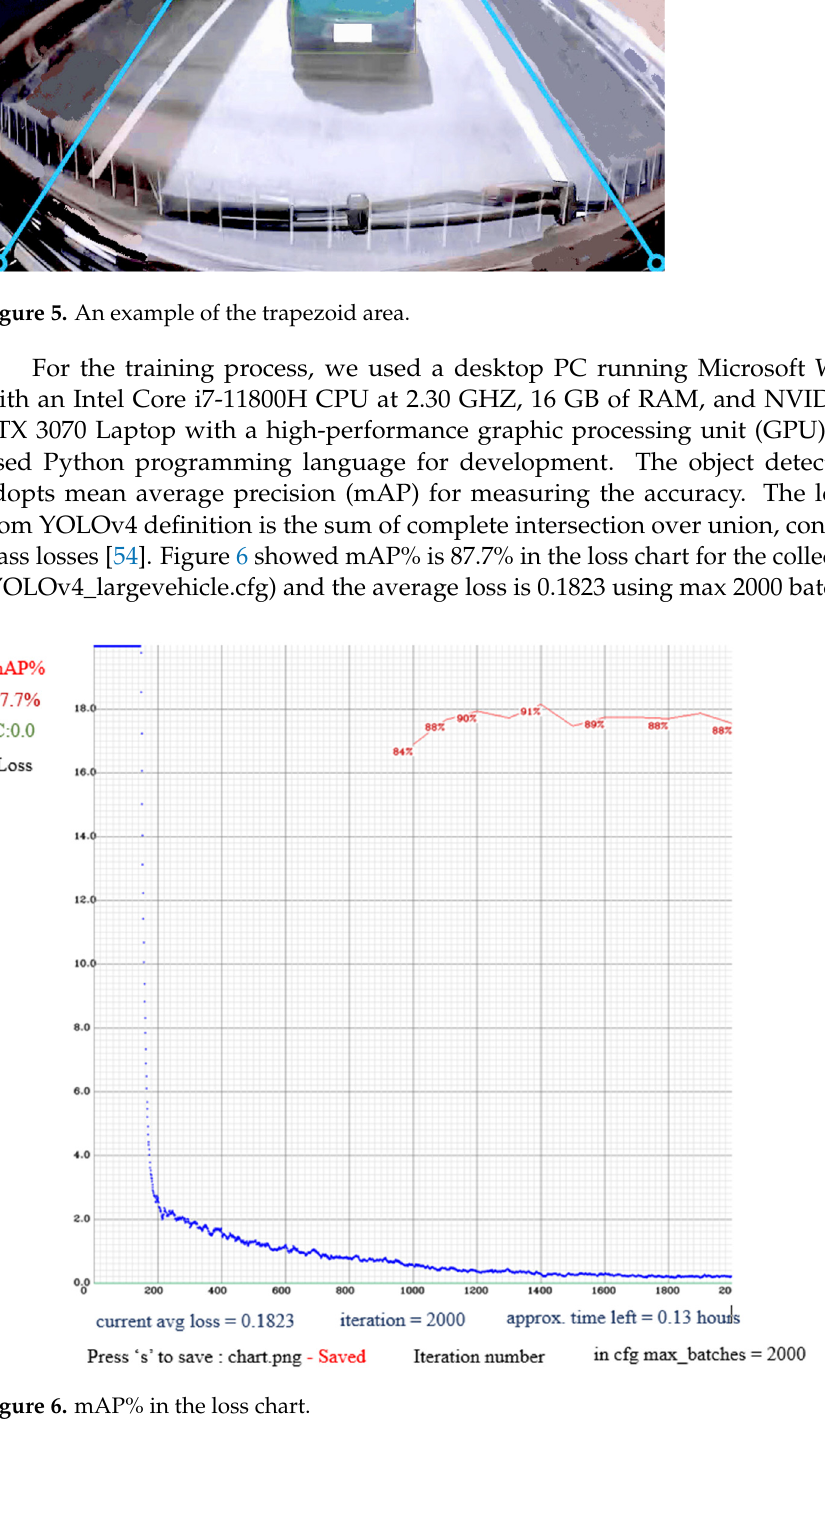
Figure 4. The collected large vehicle dataset divided into the training and validation.